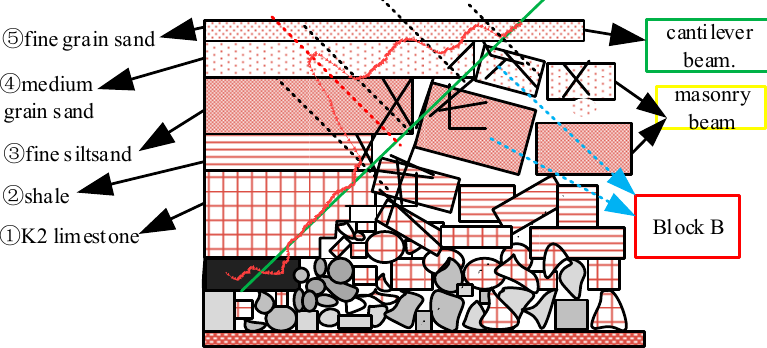
Figure 30. Schematic diagram of rock formation deformation on the fiber-optic section on 9 September.